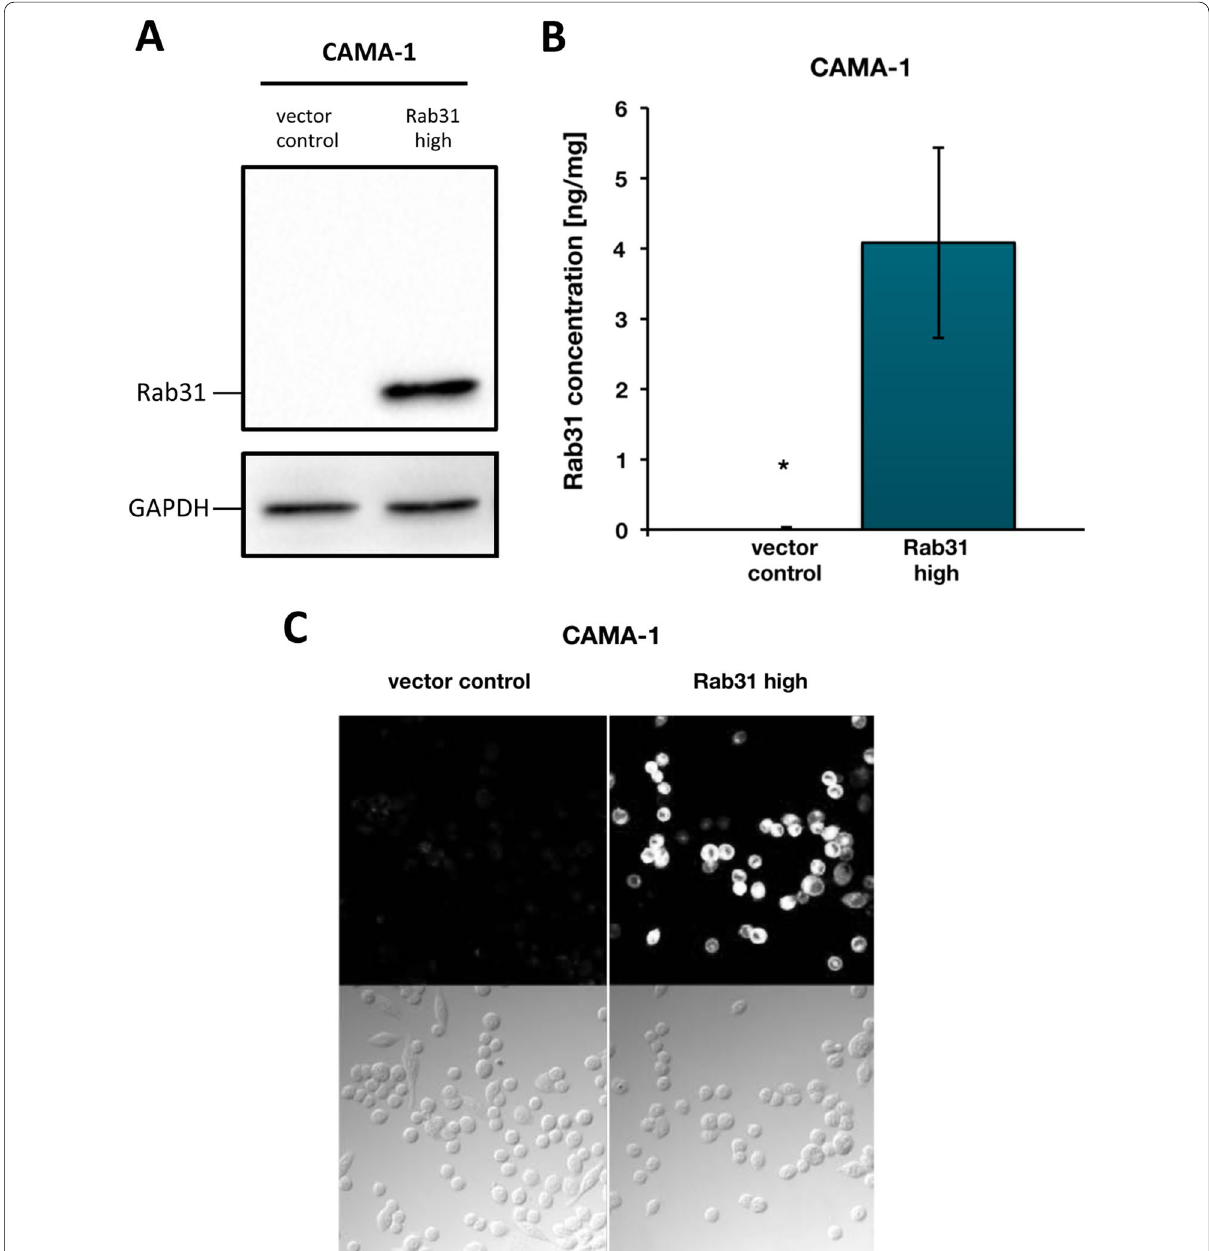
Fig. 1 Characterization of CAMA-1 breast cancer cells stably transfected with a Rab31 expression vector. CAMA-1 breast cancer cells were stably transfected with either the plasmid pRcRSV-Rab31 or with the vector alone. A Western blot analysis. GAPDH expression served as loading control. B Rab31 antigen levels in cell culture lysates, determined by ELISA. At least three experiments were performed in triplicates each. Statistically significant differences (p < 0.05) are indicated by an asterisk. C Immunocytochemical analysis of Rab31. Rab31 protein expression is presented in white in the upper panels. The lower panels show transmission images of the cells. Magnification: 20